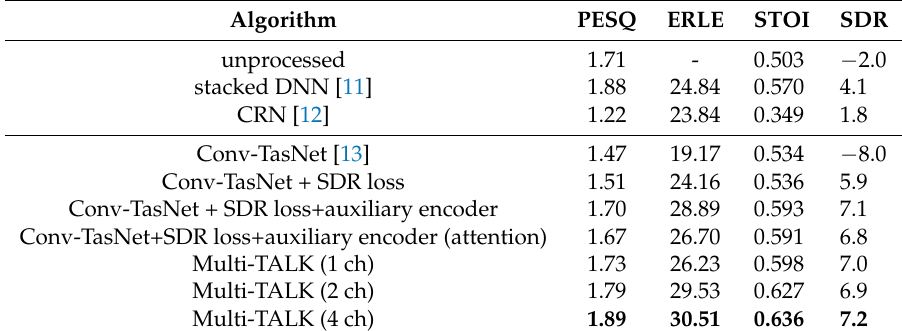
Table 5. Average PESQ, STOI, and SDR under double-talk and the average ERLE under single-talk where the far-end was a music signal with room impulse response (RIR)